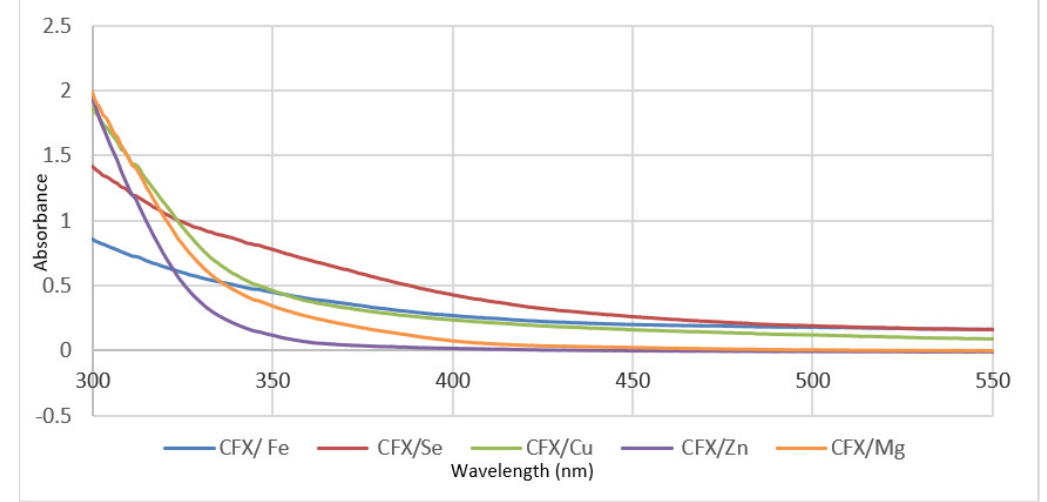
Figure 3. U.v.-vis spectra of CFX metal complexes. Figure 3. U.v.-vis. spectra of CFX metal